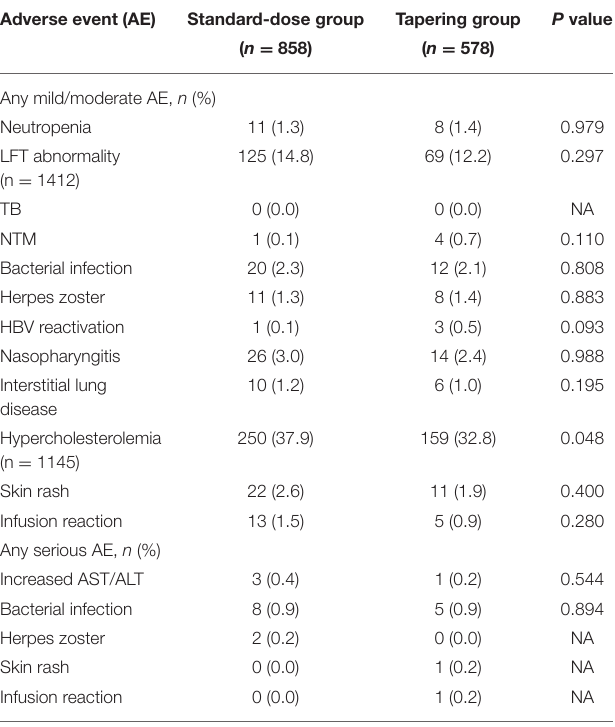
TABLE 4 | Safety assessment of tapering tocilizumab compared to its standard regimen. Adverse event